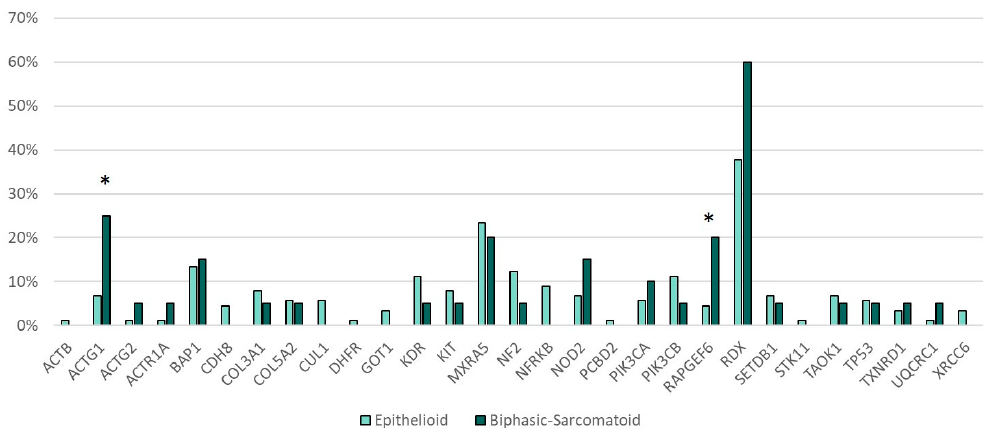
Figure 3. Gene mutations and histotype. * Statistically significant ( ACTG1 p = 0.027, RAPGEF6 p =